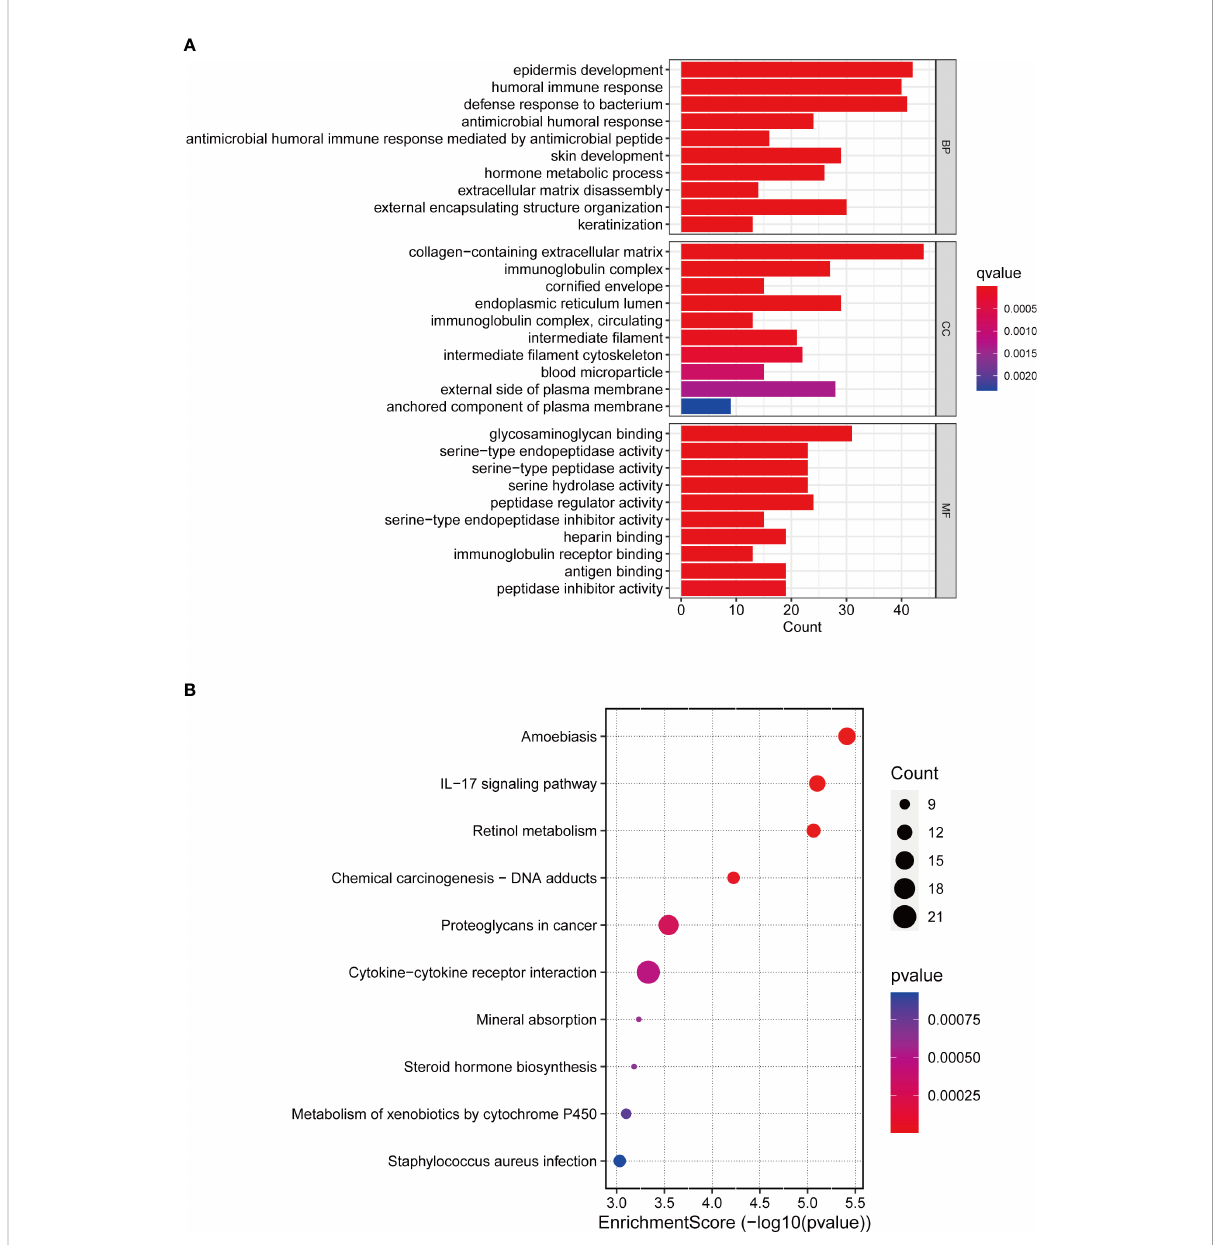
FIGURE 8 GO and KEGG enrichment analysis. (A) GO enrichment analysis in the differentially expressed genes between the low-risk and high-risk groups. (B) KEGG pathway analysis in the differentially expressed genes between the low-risk and high-risk